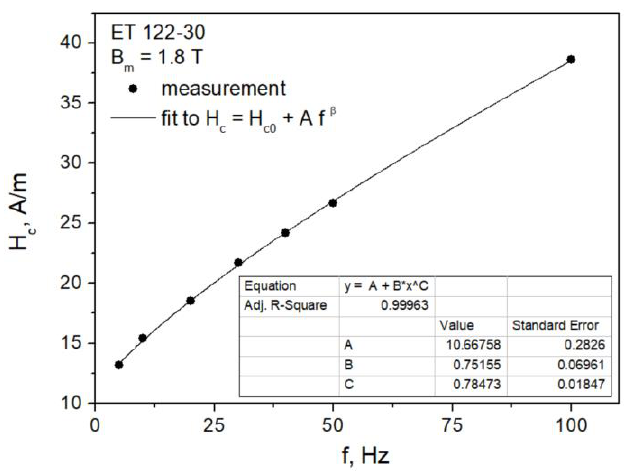
Figure 13. The measured and the modeled dependence 𝐻 c = 𝐻 c (𝑓).